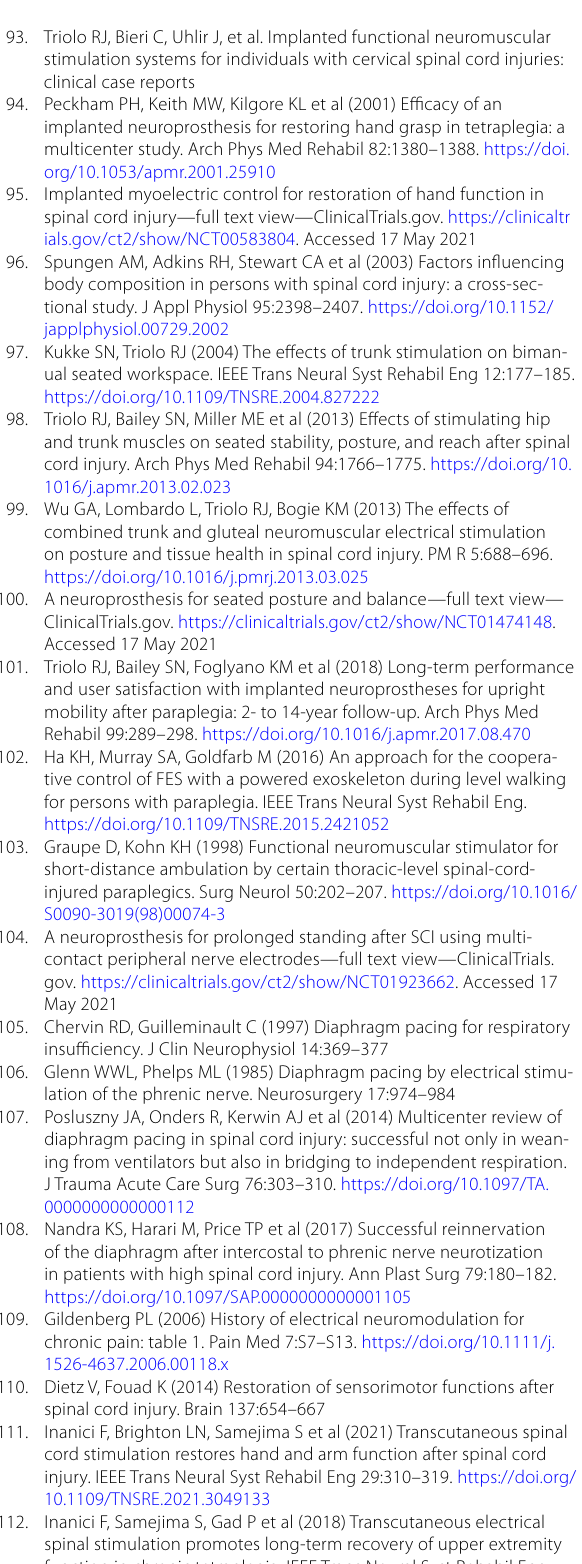
chronic pain: table 1. Pain Med 7:S7–S13. https:// doi. org/ 10. 1111/j. 1526- 4637. 2006. 00118.x 110. Dietz V, Fouad K (2014) Restoration of sensorimotor functions after spinal cord injury. Brain